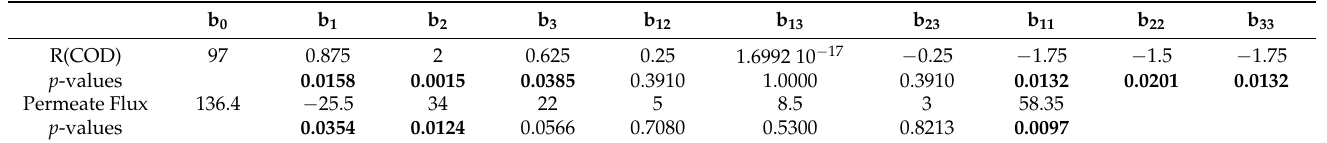
Table 5. Estimated coefficients for Permeate flux and R (COD) responses.